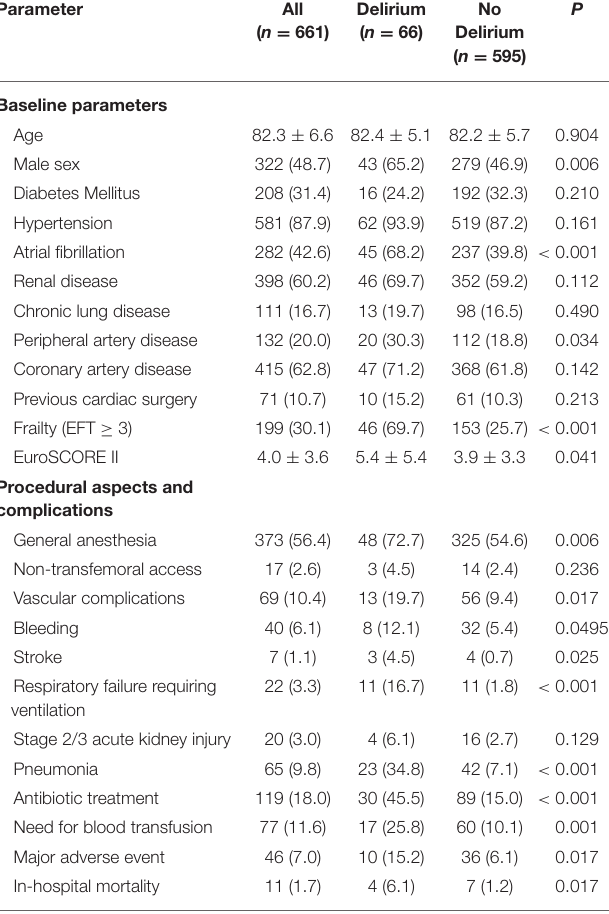
TABLE 1 | Baseline and procedural characteristics of patients with and without postoperative delirium. Parameter